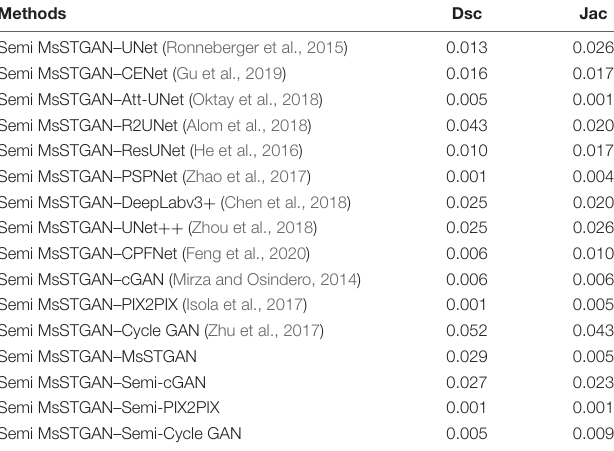
TABLE 4 | Statistical analysis ( p -value) of the proposed Semi-MsST-GAN compared with MsST-GAN and other CNN-based methods.